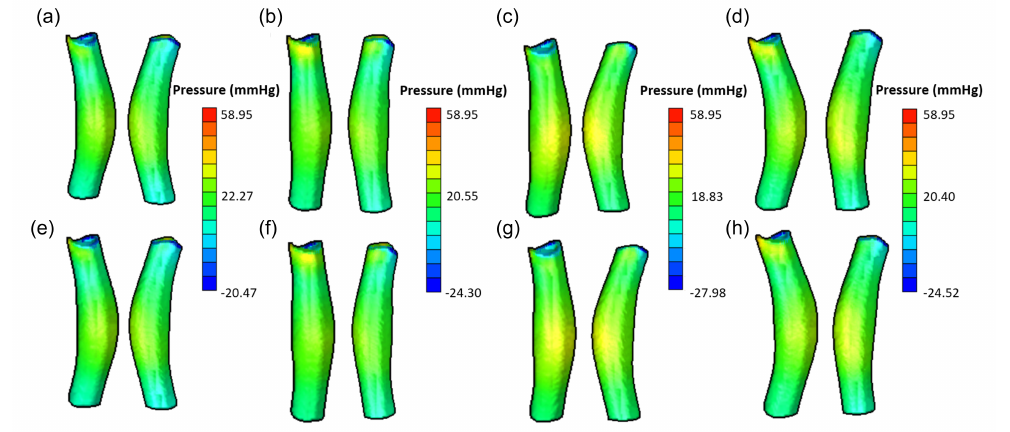
Figure 7. Pressuredistribution comparison between the CFD ( a – d ) and the ROM ( e – h ) flow field ( e – h ) for four different validation scenarios using two perspectives: No. 76 ( a – e ), No. 87 ( b – f ), No. 99 ( c – g ) and No. 101 ( d – h